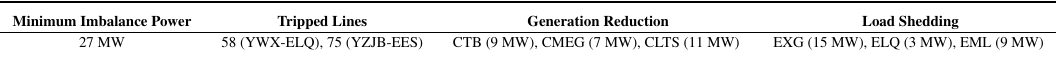
Table 6. The best splitting solution of the reduced power system of central